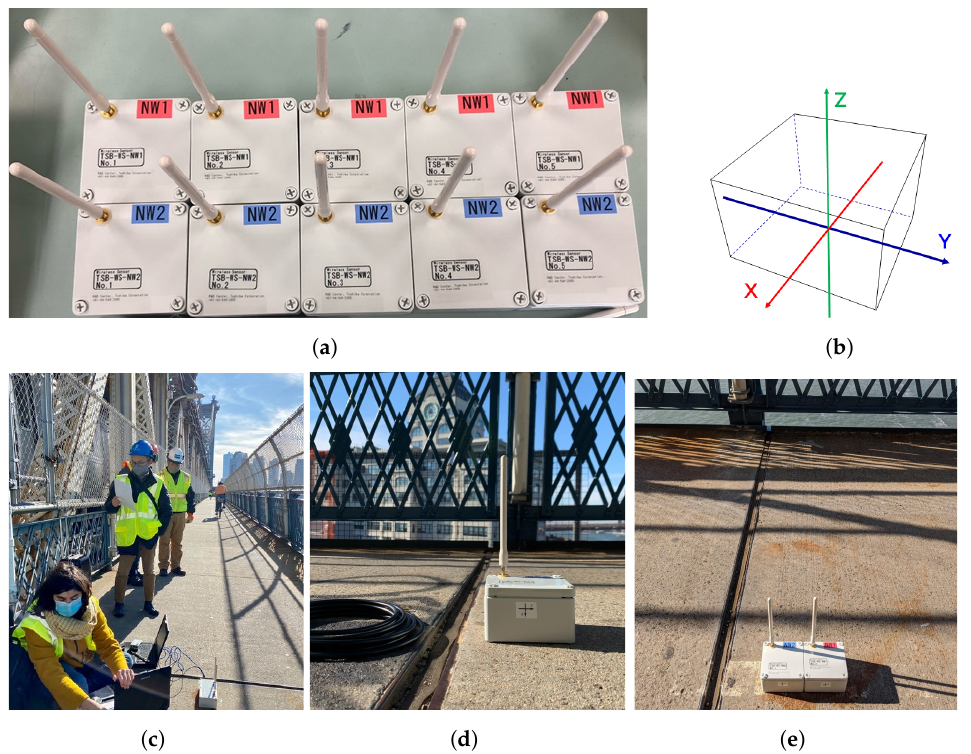
Figure 9. Sensor units for the field test: ( a ) the ten sensors in two wireless networks (NW1 and NW2); ( b ) description of the sensor axes; ( c ) sensor location 2 (cid:13) during the field test; ( d ) a sensor unit during the test; ( e ) two sensors placed in the same location for